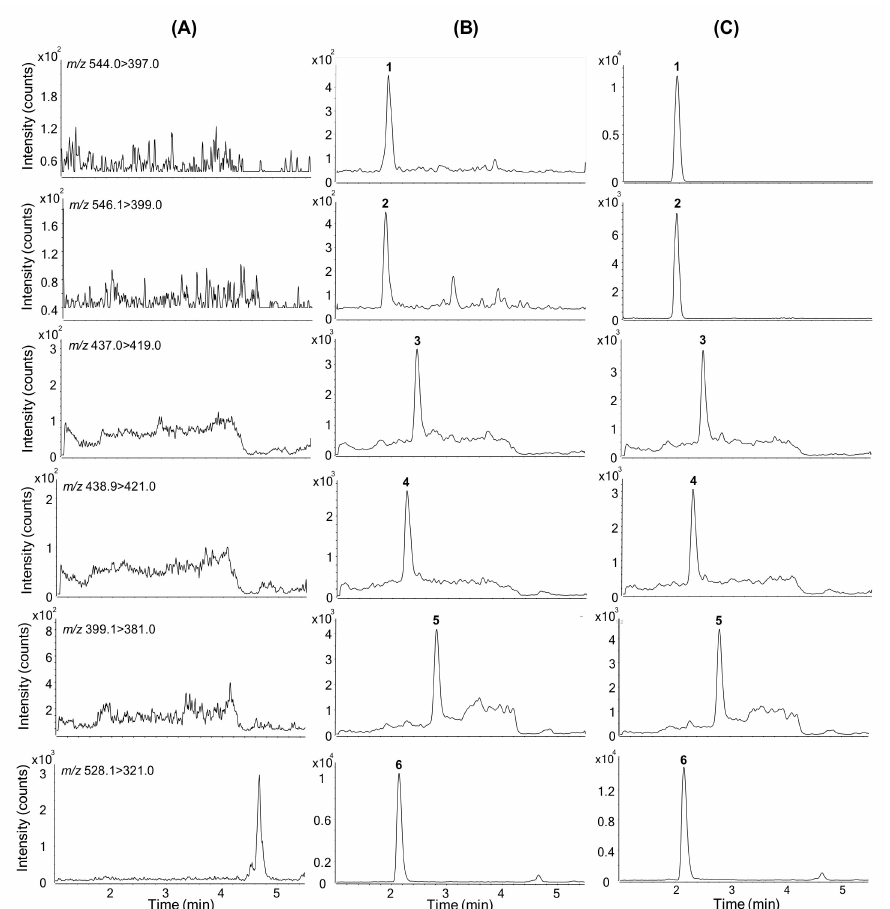
Figure 3. Selected reaction monitoring chromatograms of ( A ) mouse blank plasma: ( B ) Mouse plasma spiked with doxorubicin (0.5 ng / mL), doxorubicinol (0.1 ng / mL), doxorubicinone (0.01 ng / mL), doxorubicinolone (0.01 ng / mL), and 7-deoxydoxorubicinone (0.01 ng / mL) at the lower limit of quantification (LLOQ) levels and daunorubicin as the internal standard at 100 ng / mL; and ( C ) mouse plasma obtained 15 min after intravenous injection of doxorubicin at a dose of 1.3 mg / kg to a female BALB / c nude mouse. 1, Doxorubicin; 2, doxorubicinol; 3, doxorubicinone; 4, doxorubicinolone; 5, 7-deoxydoxorubicinone; 6, daunorubicin (internal